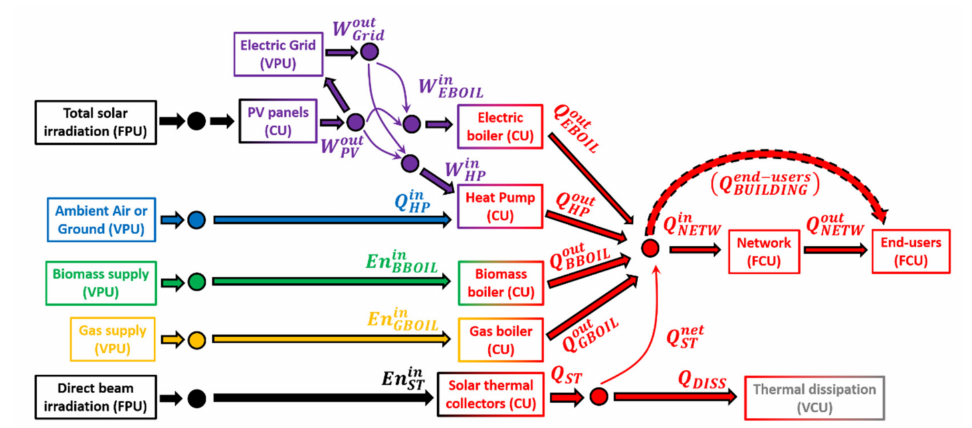
Figure A1. Graphical representation of the nodal model used in the OMEGAlpes tool. The dashed red arrow applies only at building scale. CU = conversion unit; FCU = fixed-profile consumption unit; FPU = fixed-profile production unit; VCU = variable-profile consumption unit; VPU = variable-profile production unit. The optimization tool is authorized to alter only variable profiles for optimization purposes. The rest of the units have a fixed hourly profile, predetermined by the users.